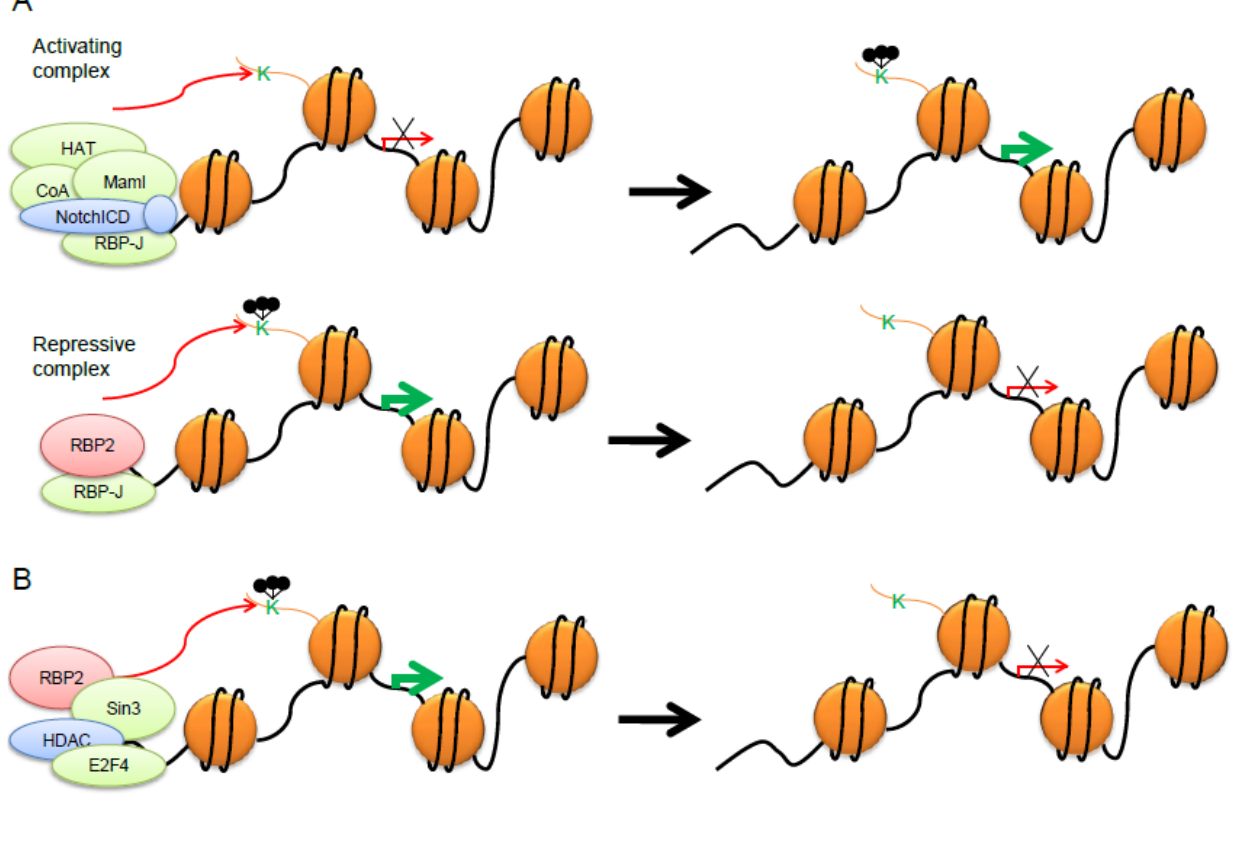
Figure 3. (A) NotchICD activates genes by recruiting RBP-J and a histone acetyltransferase (HAT) complex that adds activating marks to histones, therefore